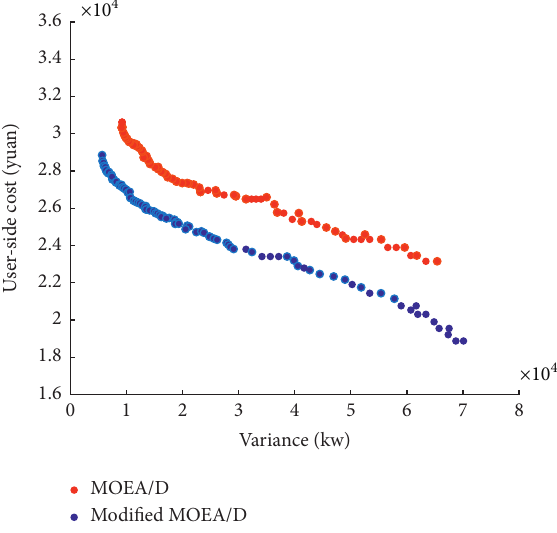
Figure 11: Algorithmic